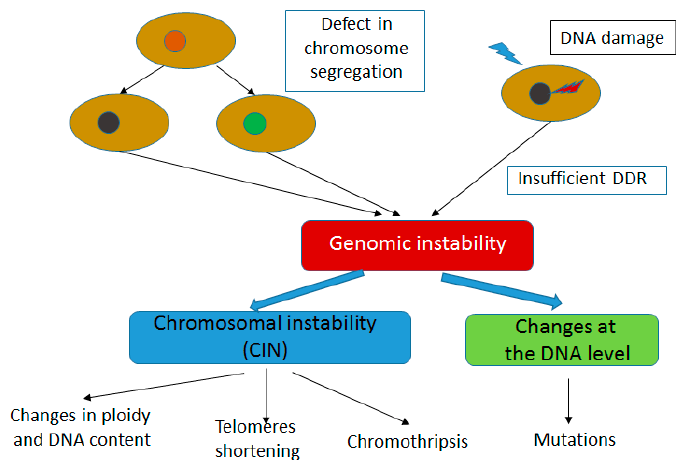
Figure 4. Genomic instability can result from defective chromosome separation, insufficient DNA damage response (DDR) or both. When the extent of endogenous or exogenous DNA damage exceeds the potential of DDR, some DNA damage can remain in the form of chromosomal aberration or changes in DNA